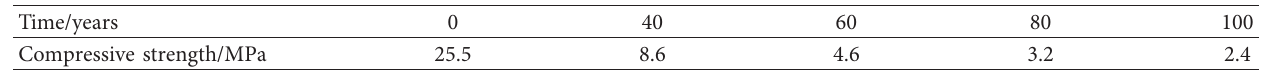
Table 4: Calculation of concrete attenuation in the protective layer at each moment.